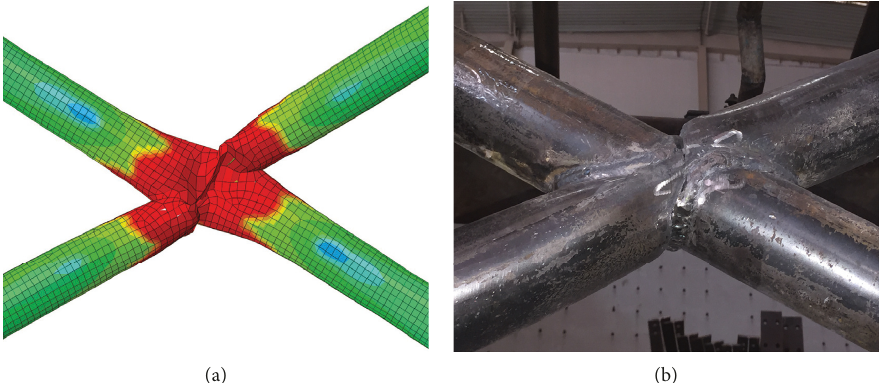
Figure 16: Failure of the brace’s cross joint (second floor). (a) FEM result. (b) Test phenomenon.